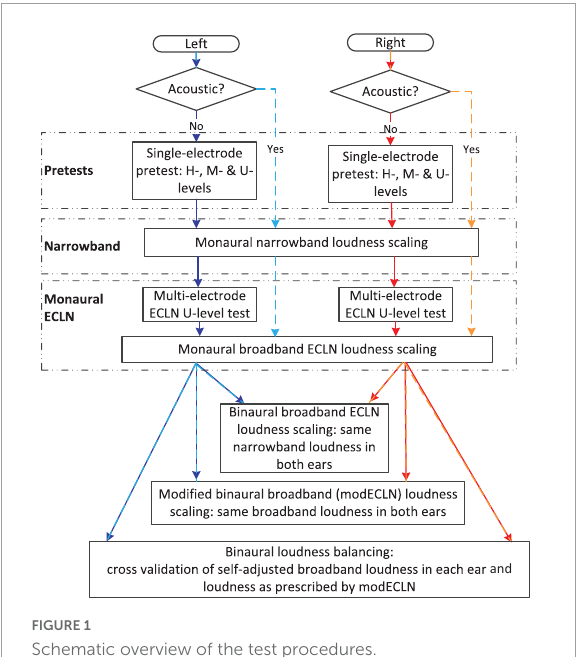
FIGURE1 Schematic overview of the test